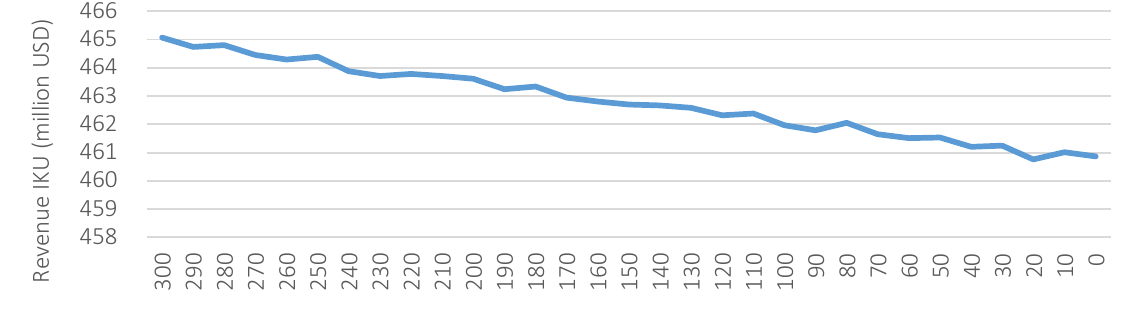
Figure 6. Realization impact on SVLK allocation to IKA income